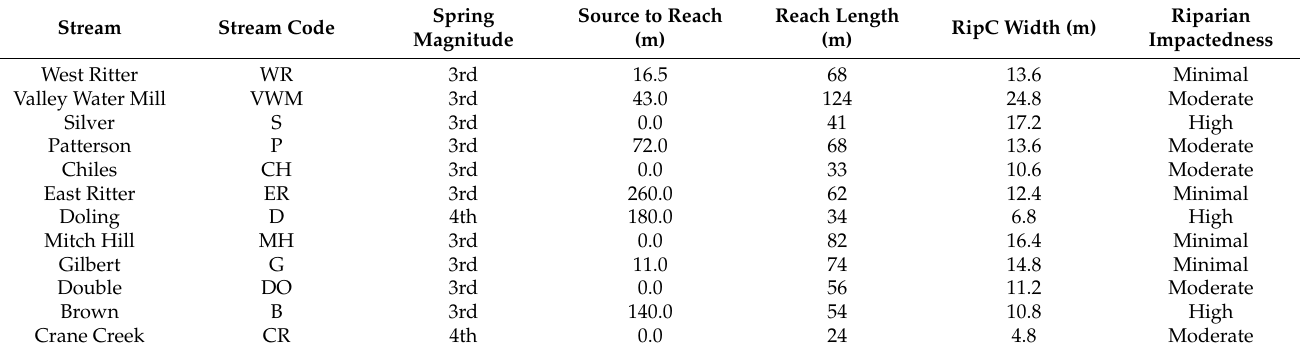
Table 1. Location and general characteristics of study streams. Includes numeric values in meters (m) for the distance between the source of each stream to the beginning of the sampling reach (Source to Reach), the total length of each stream’s sampling reach (Reach Length) and the width of the local-scale riparian zone from the left and right streambanks (RipC